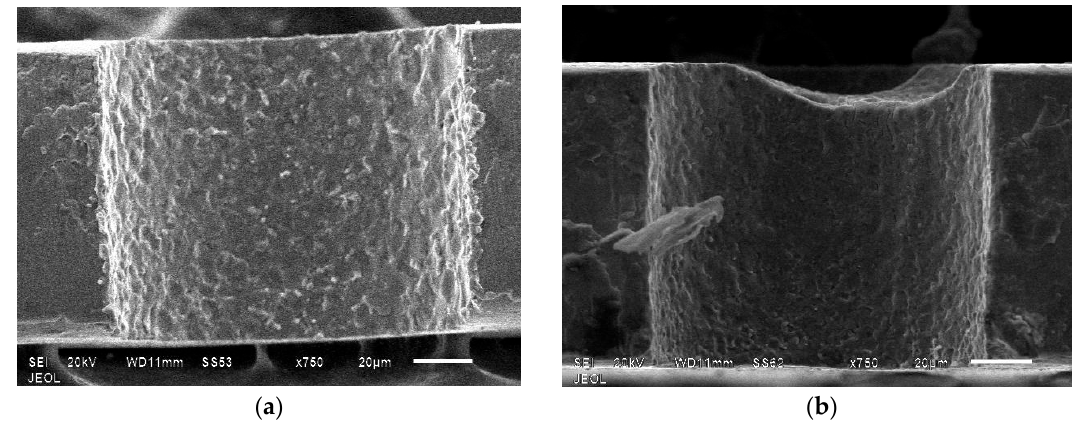
Figure 2. Scanning electron microscope (SEM) image of hole cut at edge to measure surface roughness: ( a ) using unoptimized parameters; ( b ) using optimized parameters.